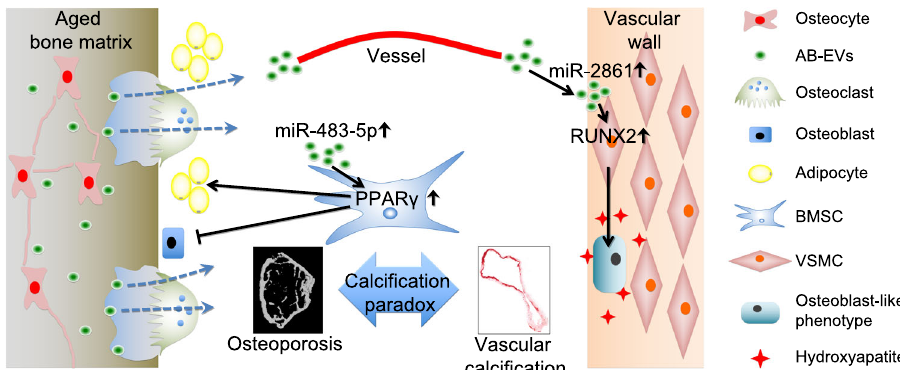
Fig. 8 Schematic diagram showing the role of AB-EVs as a messenger for calci fi cation paradox by favoring BMSC adipogenesis and VSMC calci fi cation via transferring miR-483-5p and miR-2861. During bone resorption, AB-EVs secreted by osteocytes are released from bone matrix into bone marrow, where AB-EVs promote PPAR γ expression and adipogenic differentiation of BMSCs rather than osteogenesis by delivering miR-483-5p, thus leading to bone-fat imbalance and osteoporosis. AB-EVs are also transported into circulation and deposited in blood vessels to stimulate RUNX2 expression and osteogenic transition of VSMCs via transferring miR-2861, thereby causing vascular calci fi